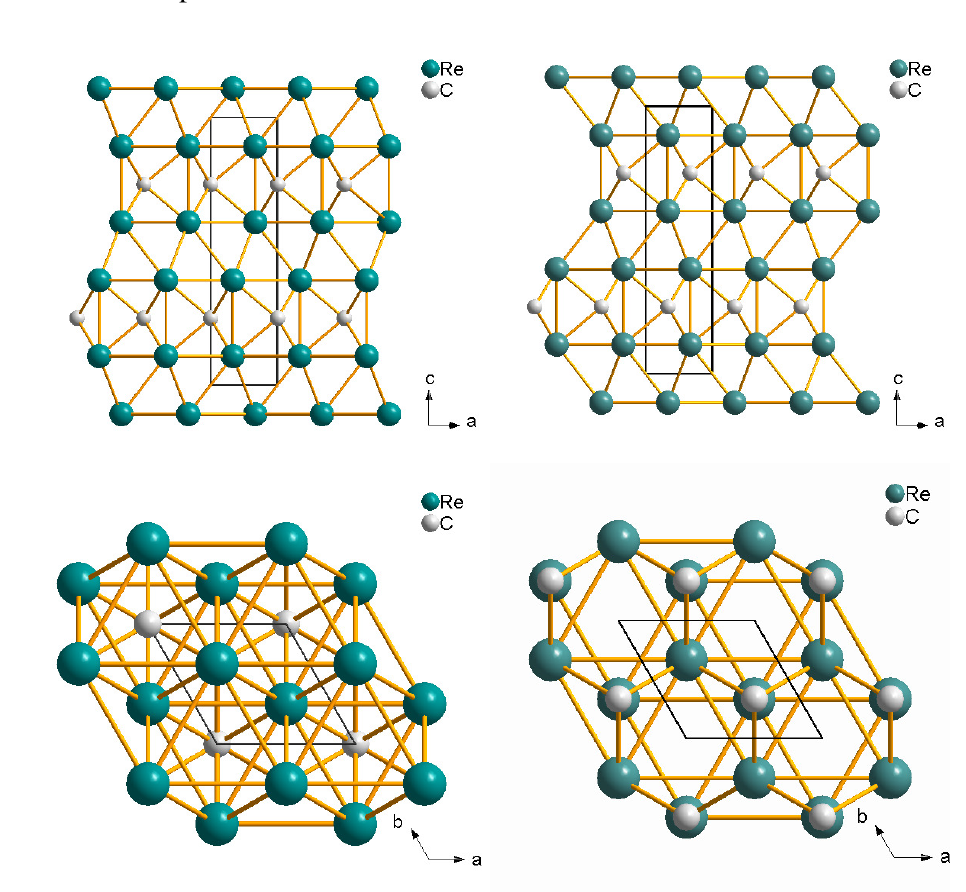
/mmc ) of anti-MoS C ( P 6 2 3 -type after Zhao et al. [115] (right). Note 2